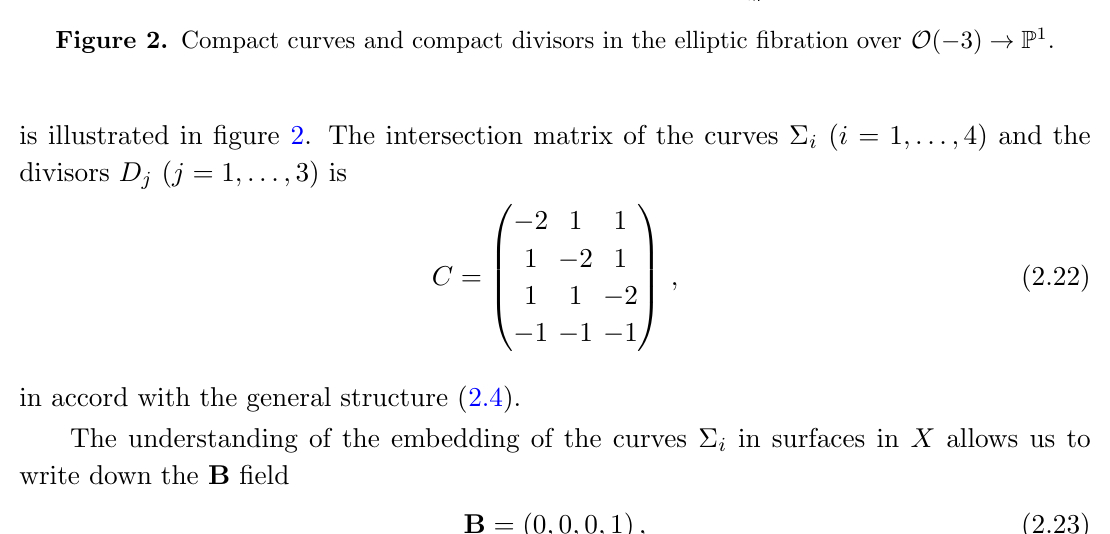
is illustrated in (cid:12)gure 2. The intersection matrix of the curves (cid:6)